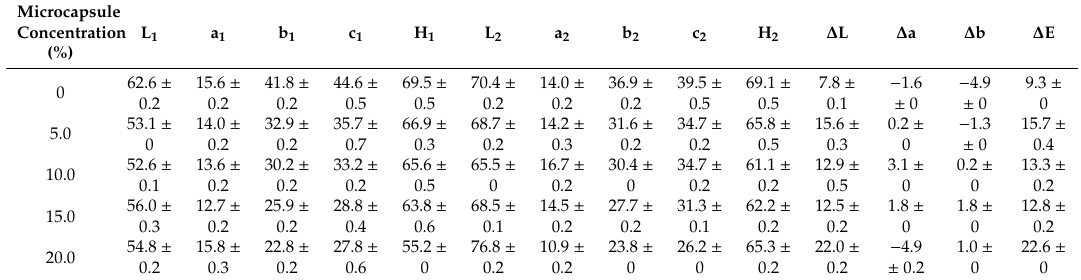
Table 8. E ff ect of microcapsules with 0.75:1 core-wall ratio on the color di ff erence. Microcapsule